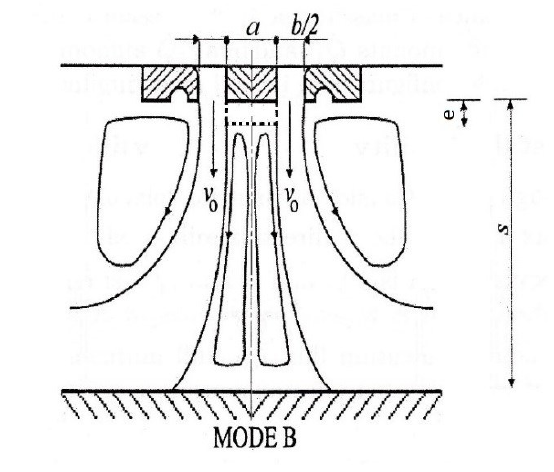
Fig. 1. Flow field patterns of type A and B [8] Here, the two main flow field patterns of the annular impinging jets will be referred to as A and B. The main characteristic of the pattern A is the existence of the reattachment point R. Below the point R, the flow field has a similar character to the flow field behind a single slot nozzle. If flow pattern A occurs, the region upstream of point R will be called the intermediate merging zone and the region downstream of point R will be called the fully merged zone. Flow pattern A is generally found for larger nozzle-to-wall